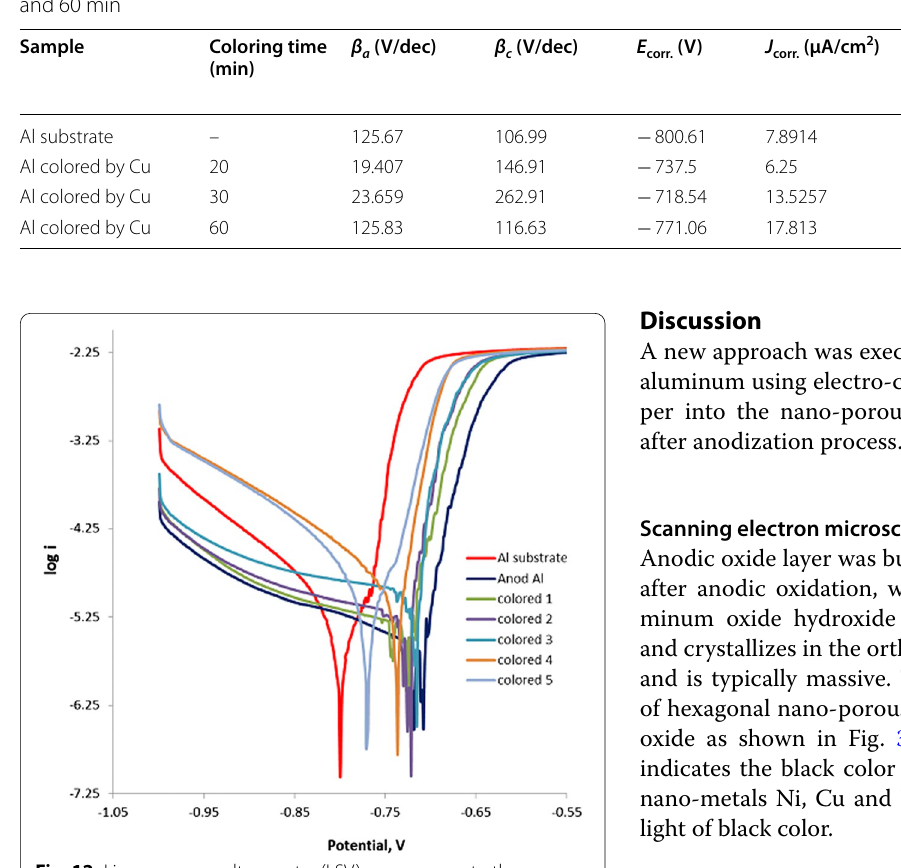
Fig. 12 Linear sweep voltammetry (LSV) measurements, the corrosion resistance of colored samples: (1—colored Ni for 30 min., 2—colored Ni/Cu for 30 min., 3—colored Cu for 20 min., 4—colored Cu for 30 min., 5—colored Cu for 60